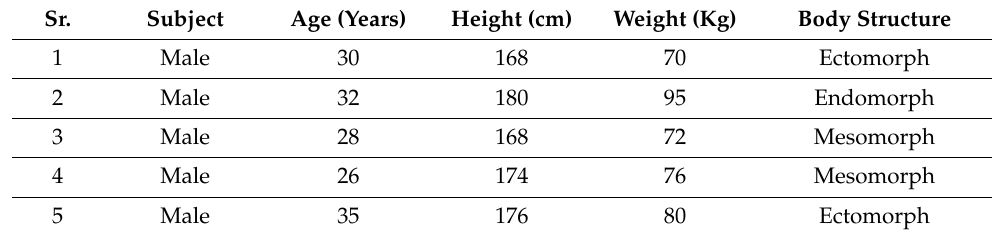
Table 3. Subjects’ participation in breathing